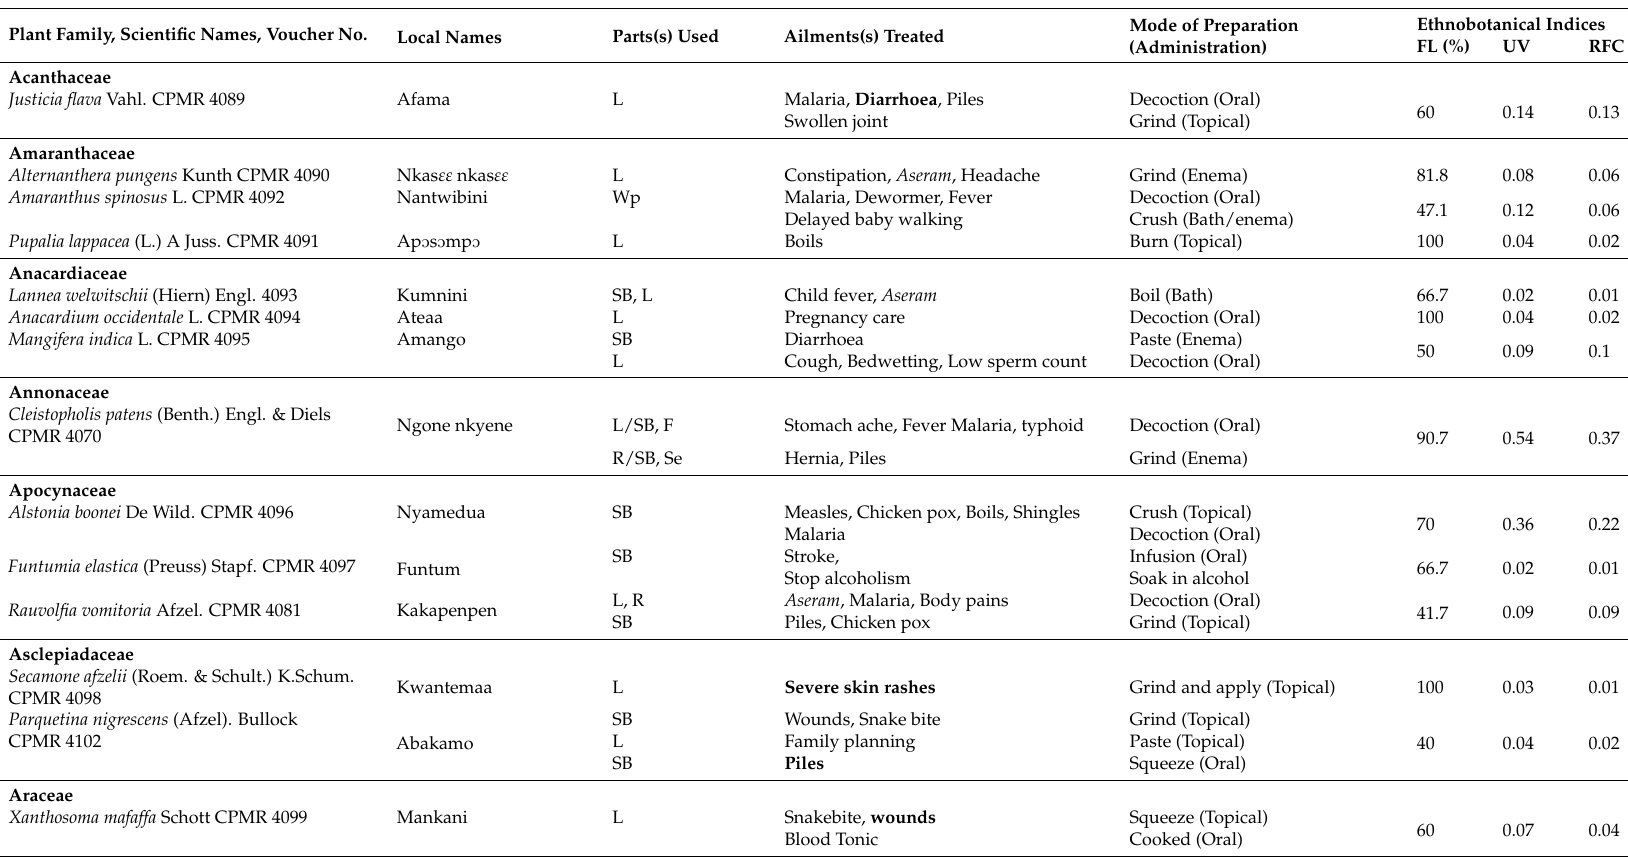
Table 2. Medicinal plants, their habit, parts used, ailments treated, cultivation status, method of preparation and administration in the Ejisu-Juaben Municipality. Plant Family, Scientific Names, Voucher